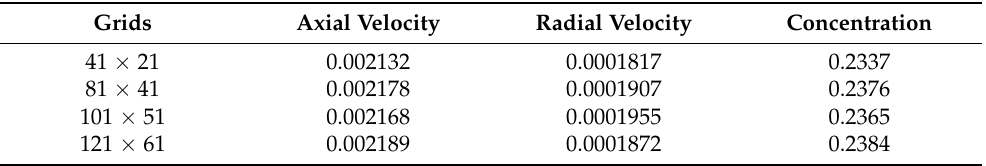
Table 2. Dimensionless velocity and concentration distribution at intermediate height surface point of the right liquid bridge ( ∆ C = 0.025, Sc = 142.8, Ca C = − 0.01, R = 2.5 mm and Ar = 1.0). Grids